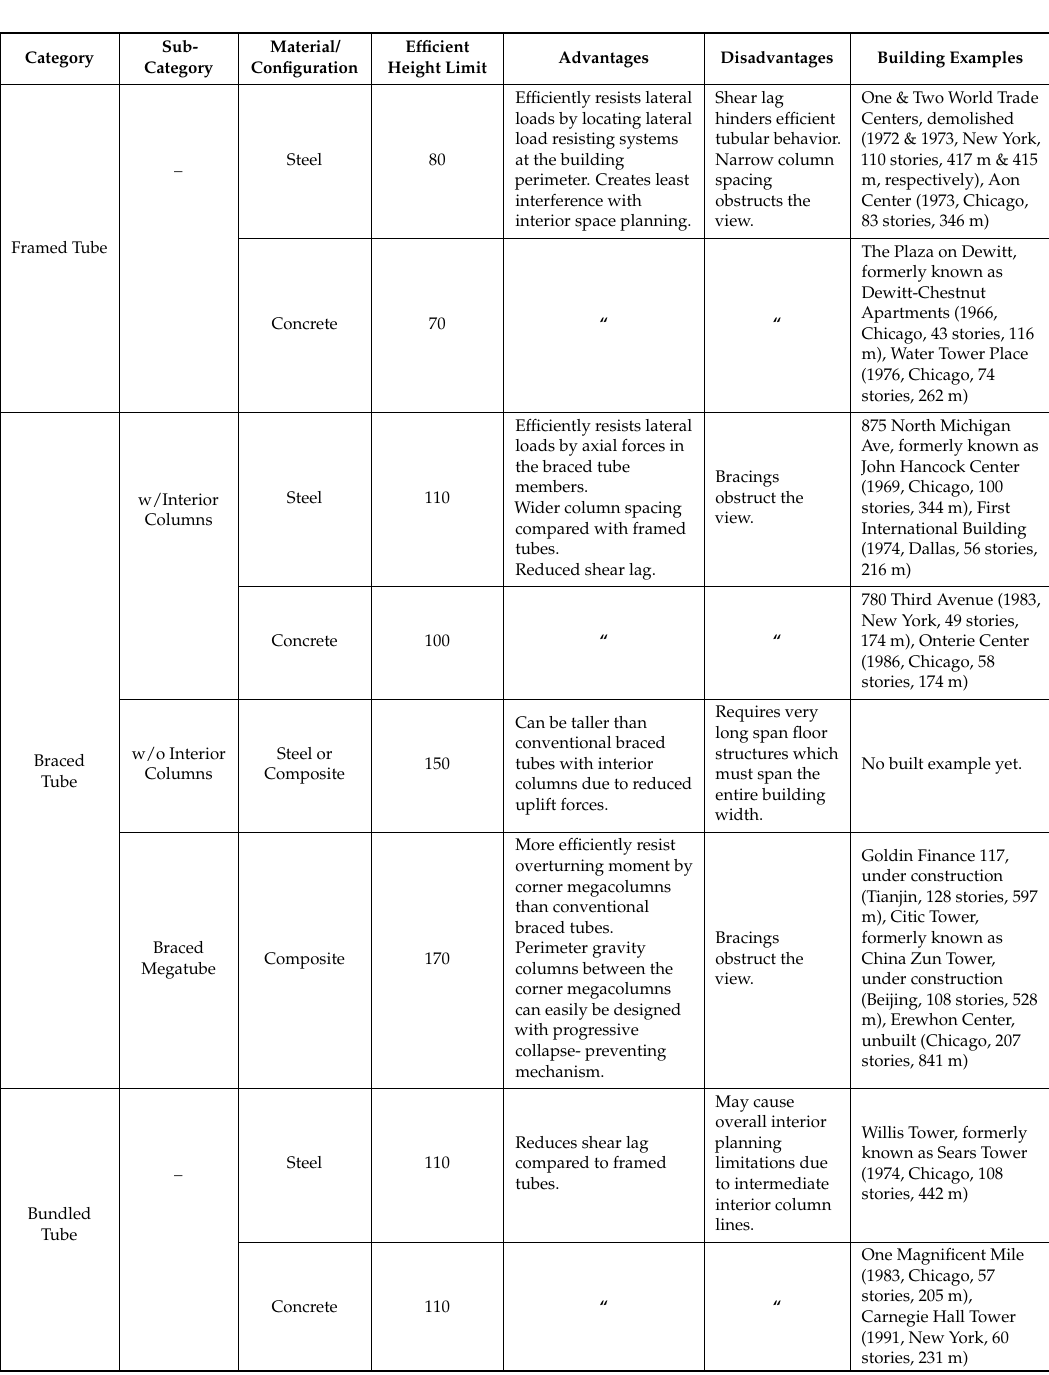
Table 2. Exterior